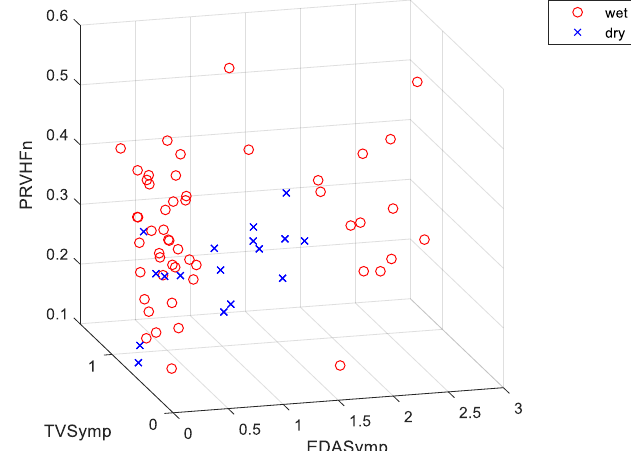
Figure 2. Scatter plot for the indices used in one of the most accurate models (accuracy = 91.2%). Classifier: subspace ensemble of k-nearest neighbor (KNN) classifiers (SE-KNN). The features are the rest measurements of: EDASymp (power spectral index of EDA), TVSymp (time-varying index of EDA), and PRVHFn (normalized high frequencies of PRV).